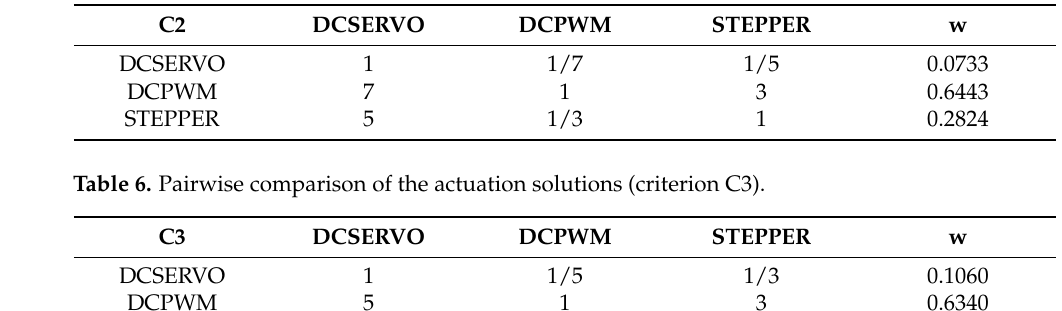
Table 5. Pairwise comparison of the actuation solutions (criterion C2).